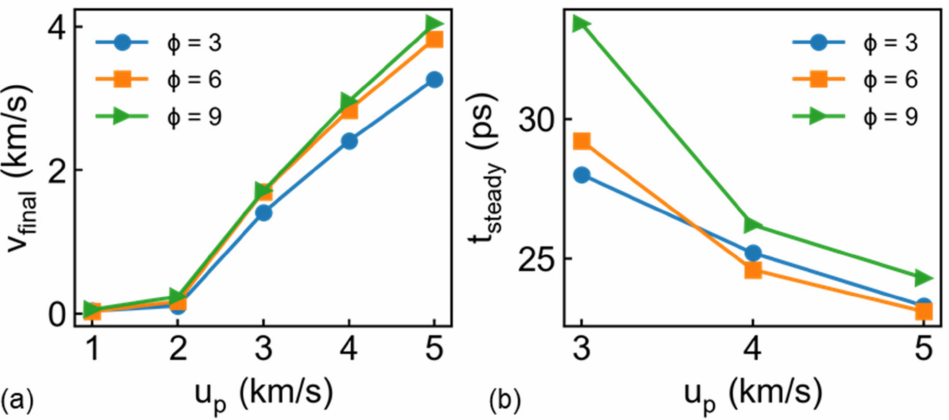
Figure 6. Relation between u p and ( a ) bullet velocity at 50 ps v final and ( b ) penetration time t steady , which is defined by the inflection point in bullet velocity